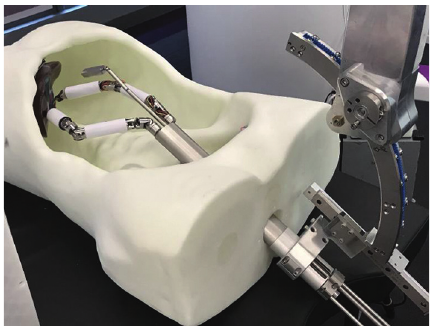
Figure 5: Robotic arm and cannula deployment in a female phantom